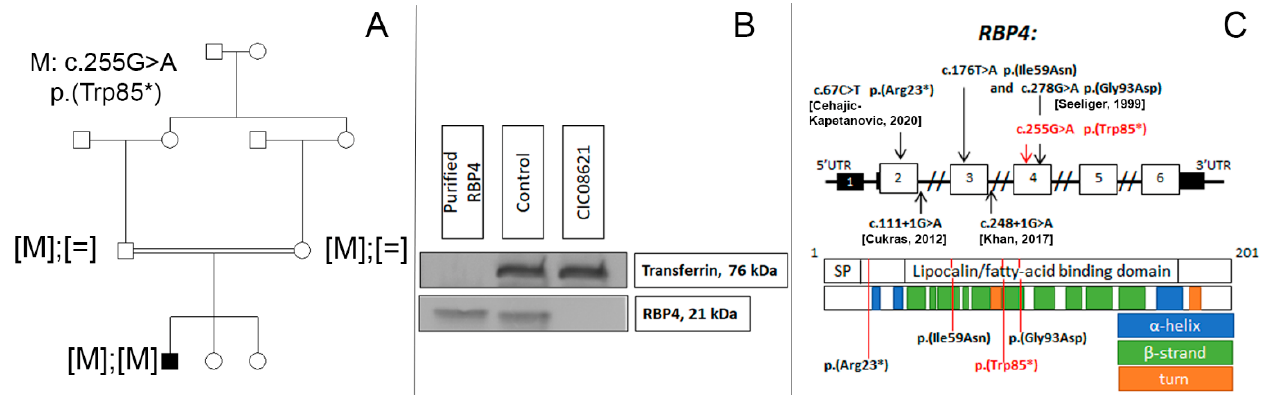
Figure 2. ( A ) Novel biallelic RBP4 variant co-segregating with the disease. ( B ) Western blot analysis Figure 2 . ( A ) Pedigree. Consanguineous family. Novel biallelic RBP4 variant co-segregating with showing the absence of RBP4 in peripheral blood of our patient (CIC08621) carrying the homozygous the disease. ( B ) Western blot analysis showing the absence of RBP4 in peripheral blood of our patient nonsense variant in RBP4, compared to an unaffected control and recombinant RPB4. Transferrin (CIC08621) carrying the homozygous nonsense variant in RBP4, compared to an unaffected control is used as serum loading control. ( C ) RBP4 gene and protein structure. SP—signal peptide domain. and recombinant RPB4. Transferrin is used as serum loading control. ( C ) RBP4 gene and protein Disulfide bonds (22-178, 88-192, 138-147) are not shown. Previously reported and novel (in red) structure. SP—signal peptide domain. Disulfide bonds (22-178, 88-192, 138-147) are not shown. Pre- variants linked with inherited retinal degeneration viously reported and novel (in red) variants linked with inherited retinal degeneration [15-18].